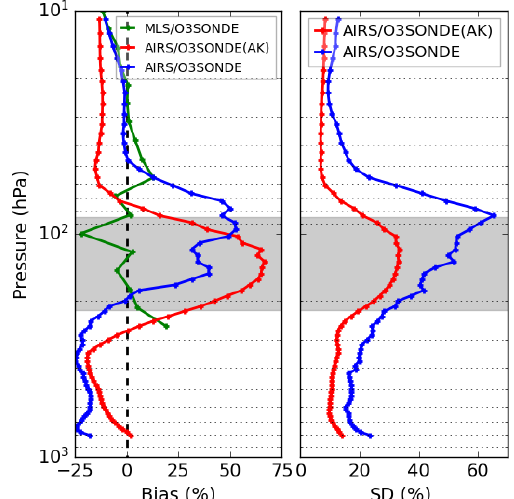
Figure 7. Statistical error analysis (bias and standard deviation) of AIRS-retrieved ozone with ozonesonde and ozonesonde (AK) for collocated data of 7 years (2011–2017). The bias between col- located data of MLS (261–10hPa) and ozonesonde over Nainital during 2011–2017 is also shown with the green profile. The grey shaded area shows the tropopause region from balloon-borne ra- diosonde